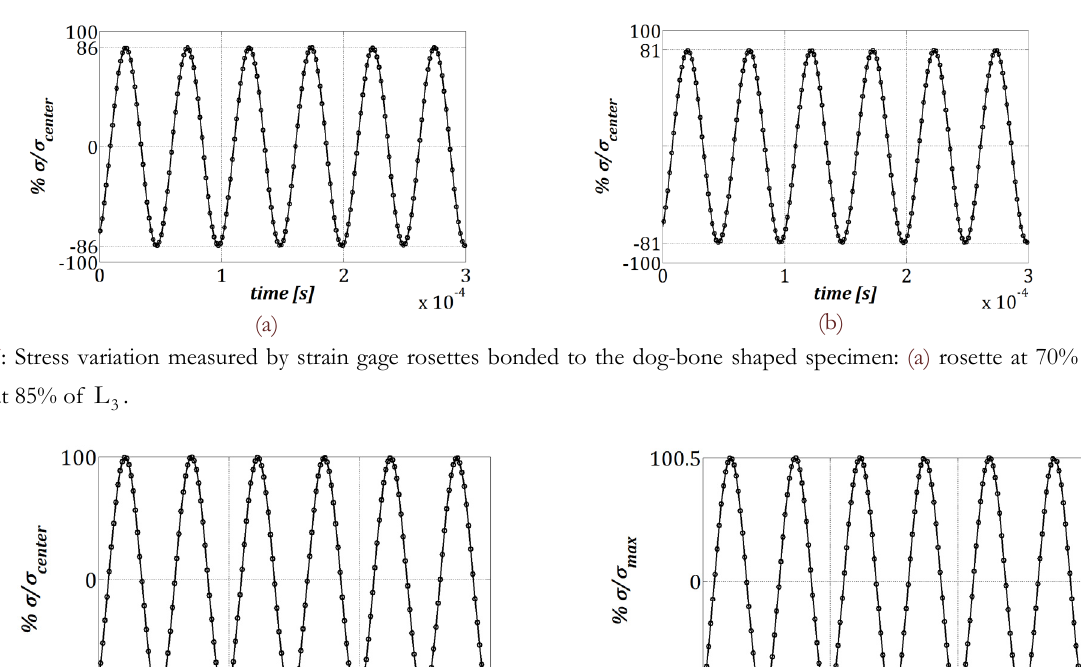
Figure 8: Stress variation measured by strain gage rosettes bonded to the Gaussian specimen: (a) rosette at 70% of